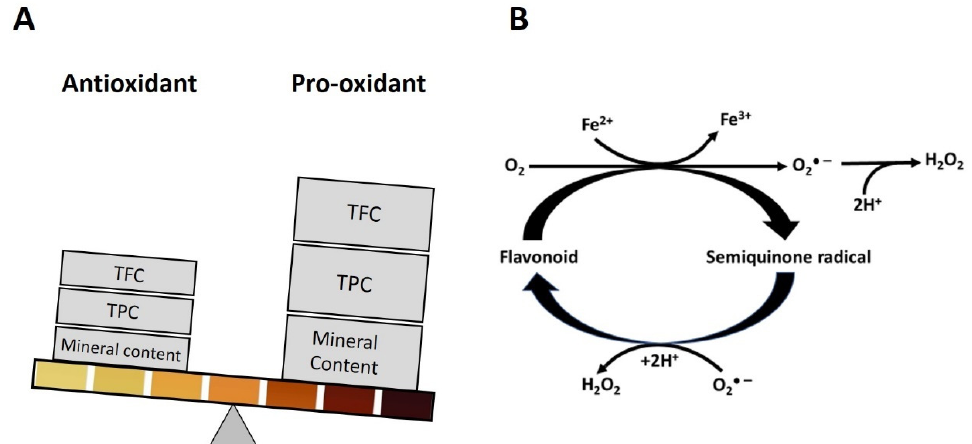
Figure 3. A schematic depiction of the quantitative differences in the total polyphenolic content (TPC), total flavonoid content (TFC) and mineral content in the relation to honey color (based on correlative coefficients of Table 2) that change the antioxidant- pro-oxidant balance ( A ) and produce a marked flux of H 2 O 2 ( B ). The gradient of honey color illustrates the corresponding increase of TFC, TPC and mineral